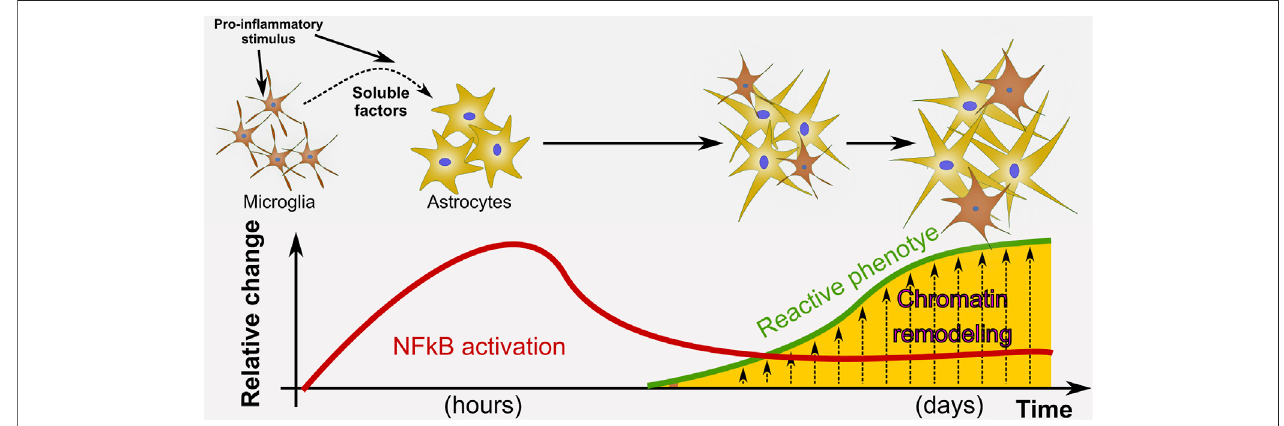
FIGURE 7 | Proposed model of astrocyte phenotype conversion. We propose a model in which a pro-in fl ammatory stimulus such as LPS activates NF- κ B in astrocytes and promotes pathological remodeling of reactive astrocytes with pro-in fl ammatory gain of function only when microglia is present. In our in vitro paradigm, cell-to-cellcommunicationtoactivateNF- κ Bnucleartranslocation doesnotdependonphysicalcontactwithmicrogliabutonthereleaseofsolublefactors. Wepropose that after NF- κ B initial activation, the astrocyte reactive phenotype is sustained by epigenetic changes at the chromatin